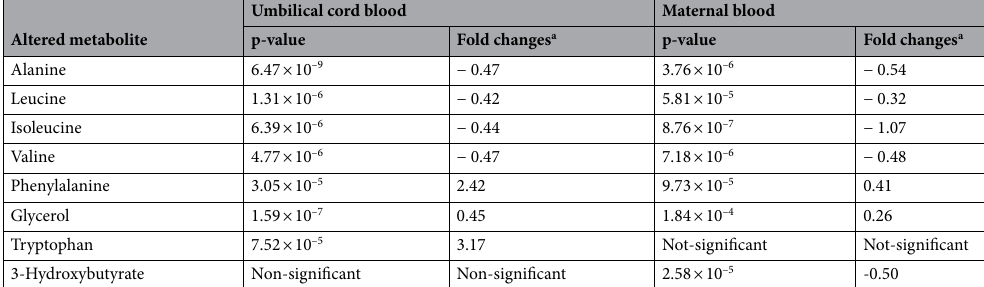
Table 2. P-values and fold changes for significant metabolites among umbilical and maternal blood samples. a Positive values indicate metabolites determined in higher concentration in the AGA group whereas negative values indicate metabolites determined in higher concentration in the IUGR